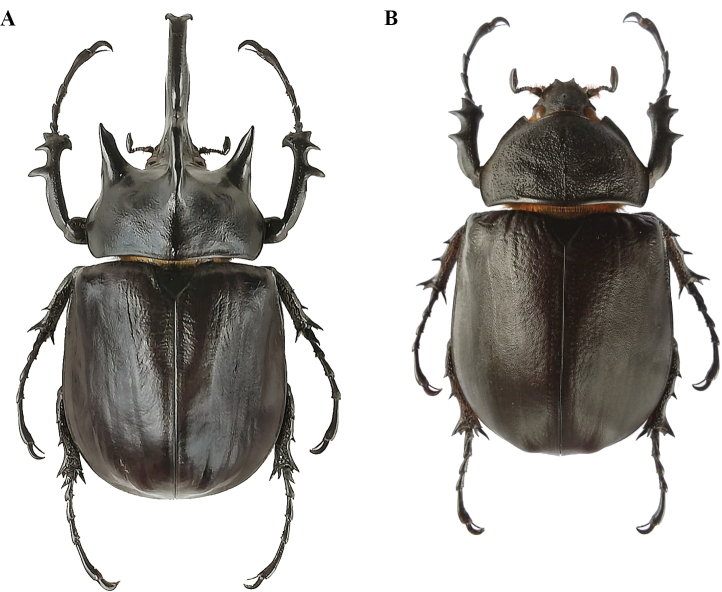
AM.
hermes ♂ BM.
hermes ♀.